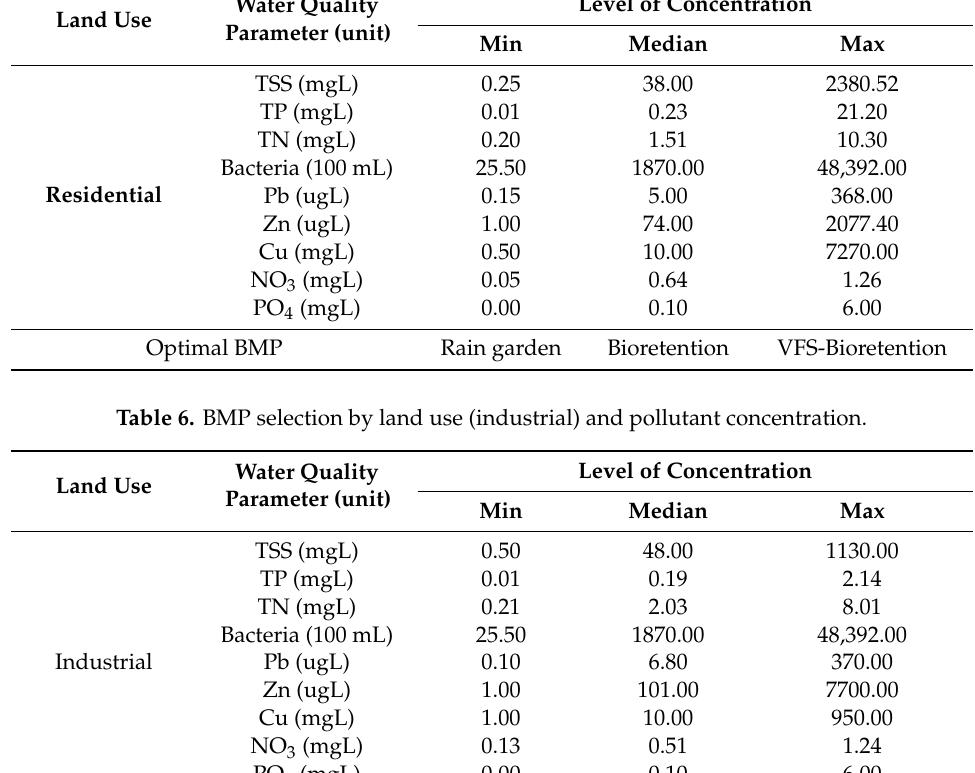
Table 5. BMP selection by land use (residential) and pollutant concentration. Land Use